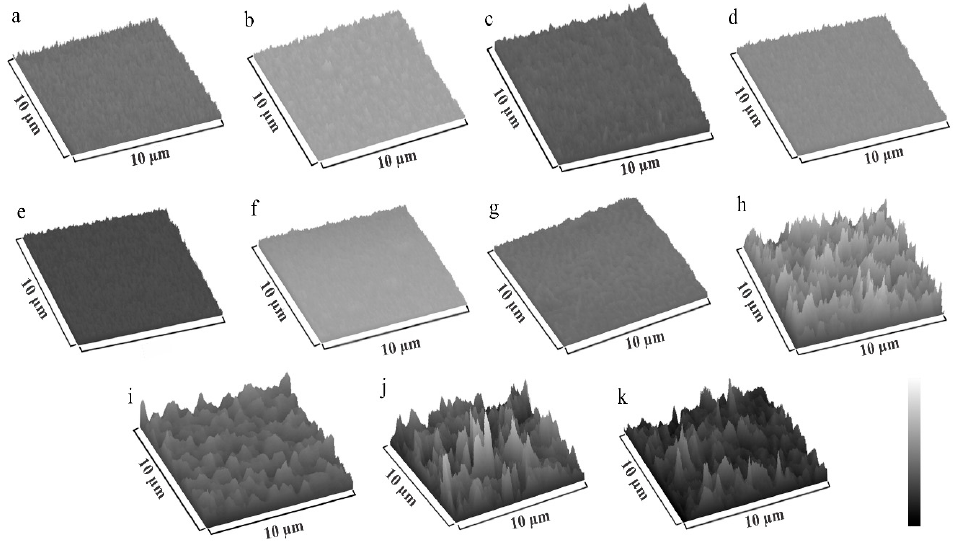
Figure 6. 3D surface plot of: ( a ) PDMS (SEM image from Figure 1); ( b ) Ag:HAp (SEM image from Figure 2a); ( c ) Ag:HAp-PDMS layer (SEM image from Figure 2a); ( d ) Zn:HAP (SEM image from Figure 2b); ( e ) Zn:HAP-PDMS (SEM image from Figure 2b); ( f ) HAp (SEM image from Figure 2c); ( g ) HAp-PDMS (SEM image from Figure 2c); ( h ) Zn:HAp (SEM image from Figure 3); ( i ) Zn:HAp-PDMS